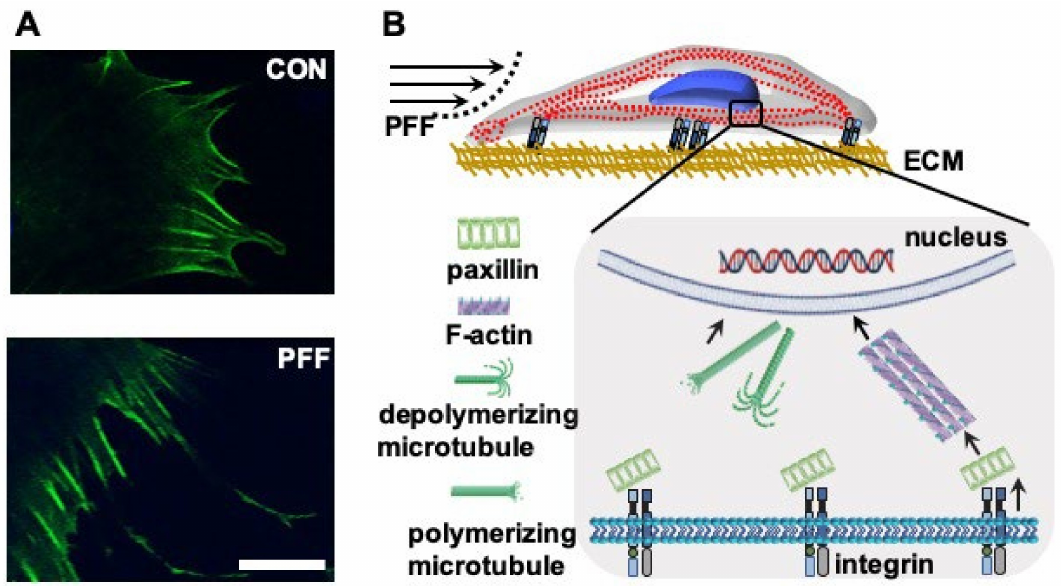
Figure 7. E ff ect of 1 h PFF on F-actin distribution at the cell boundary, and schematic summary of the changes induced by PFF in MC3T3-E1 osteoblasts. ( A ) F-actin was visualized using phalloidin. Upper image: control cell. Lower image: PFF-treated cell. Bar = 25 µ m. ( B ) PFF was sensed through integrins, which formed clusters of α and β -integrins. Paxillin changed from granular to short rods. F-actin was neatly arranged, and F-actin fluorescence intensity was increased by PFF. The morphology and volume of the cell body and nucleus changed in response to PFF, which might result in changed cell function. CON, control; PFF, pulsating fluid